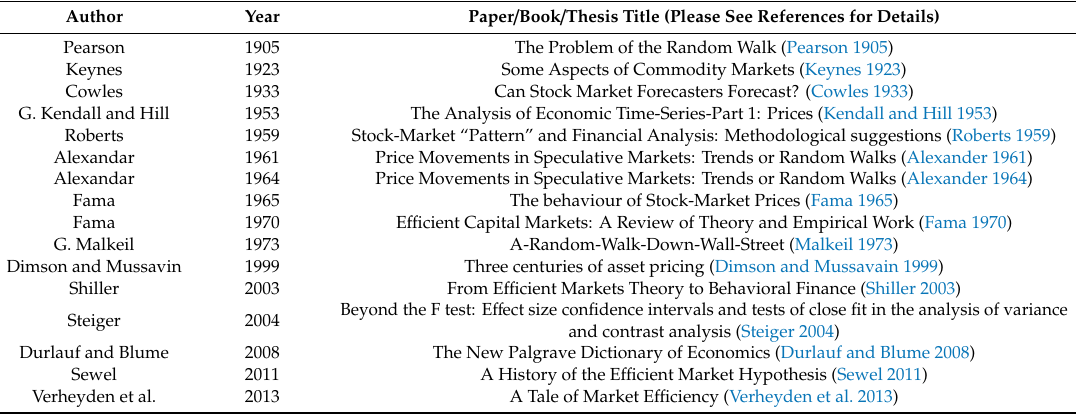
Table 1. Selected work on Development of e ffi cient market hypothesis